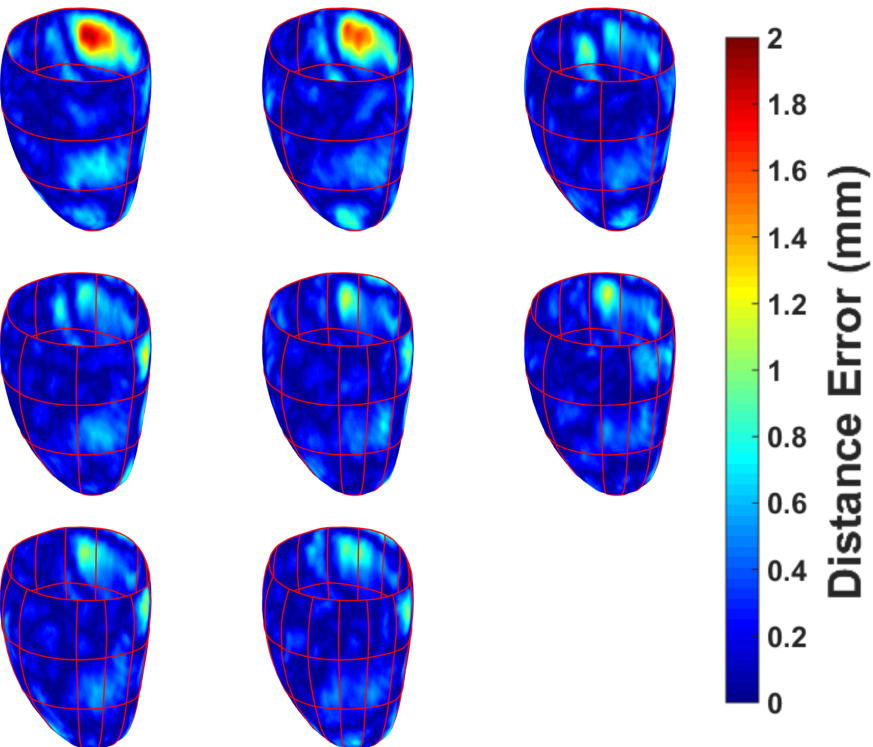
Figure 6. The effect of increasing the amount of left epicardial LAX contours have on the error distance between the generated mesh and the ground truth mesh. Top to bottom: 1–8 LAX slices added, successively. Each LAX added is a rotated version of the first LAX shown in the first row, first column. Rotations were generated as per the following: 90, 45, 135, 22.5, 157.5, 112.5, 67.5 degrees,